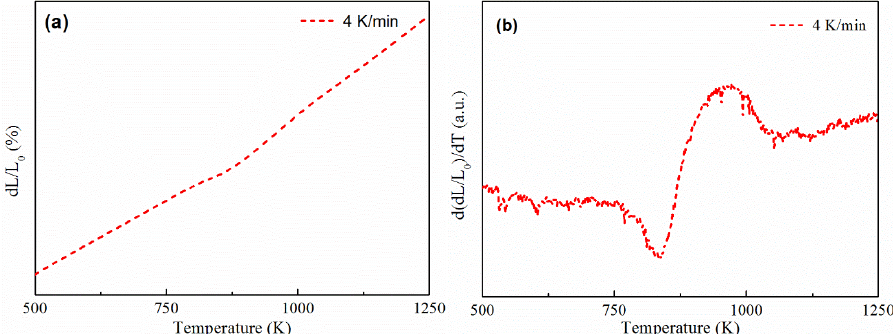
Figure 1. ( a ) The thermal dilation curve of Al 0.25 CoCrFeNi high-entropy alloy measured at 4 K/min heating rate, and ( b ) the differential of the thermal dilation